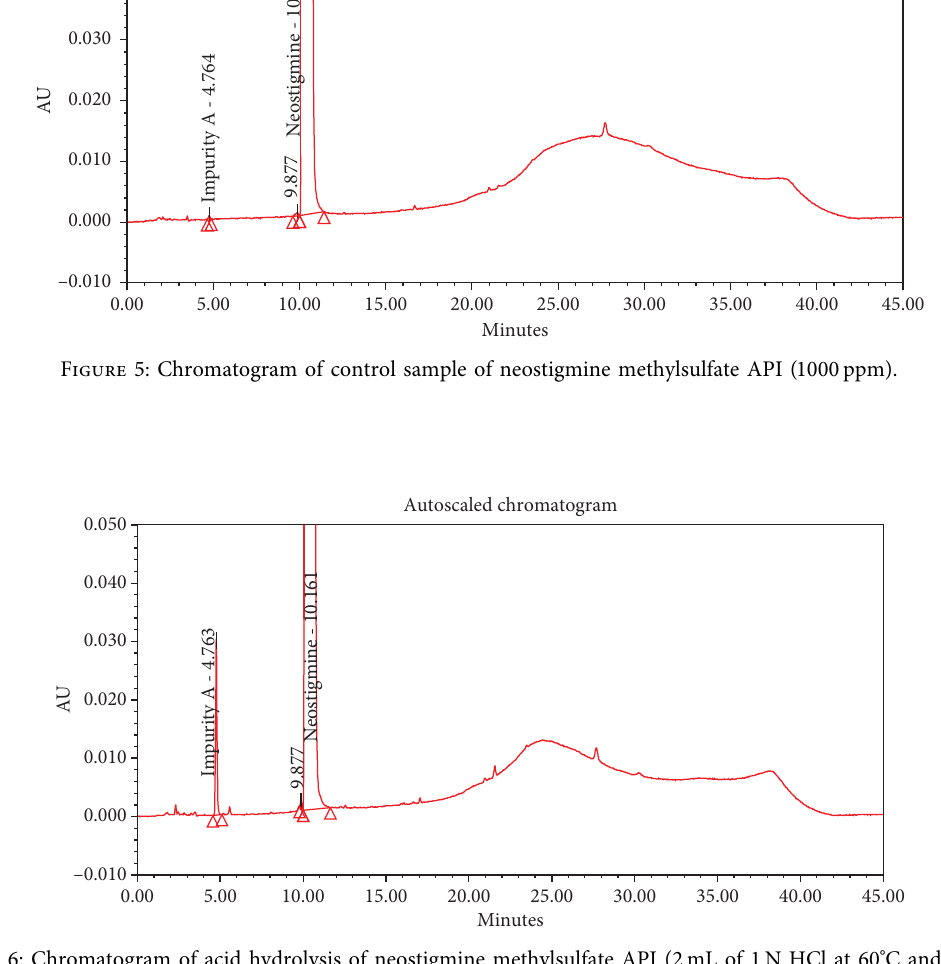
Figure 6: Chromatogram of acid hydrolysis of neostigmine methylsulfate API (2mL of 1N HCl at 60 ° C and 30min).